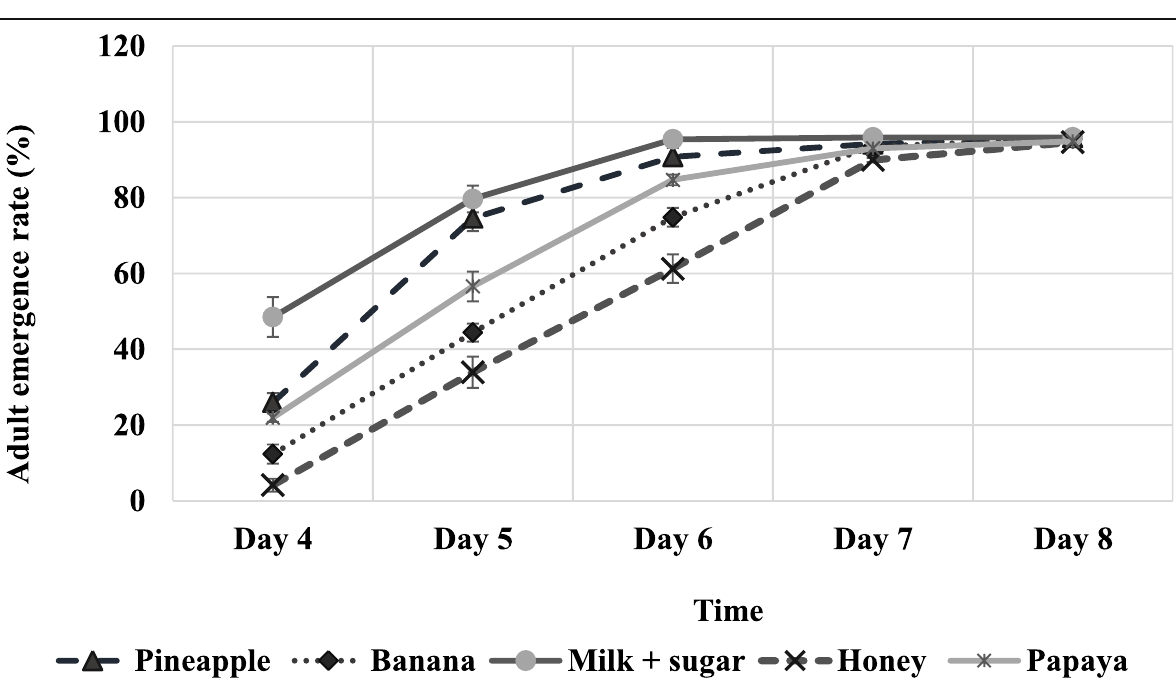
Fig. 4 Evolution of the cumulative emergence rate of M. domestica adults according to the food-based rearing system. Error bars represent standard deviation